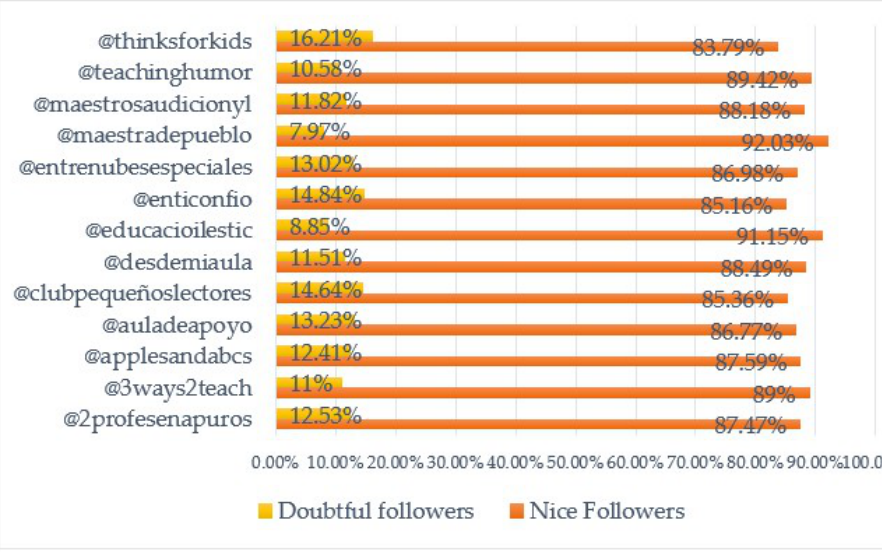
Figure 2. Percentage statistics (Quality of the audience). Source: Own elaboration.